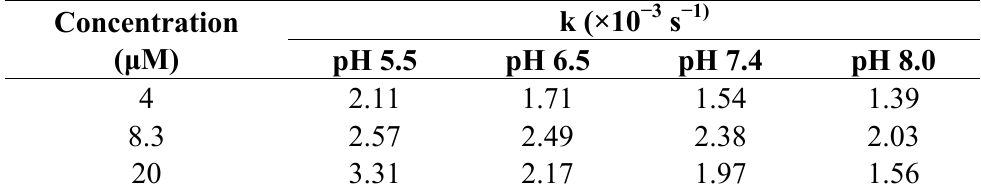
Table 5. Investigation for chemical degradation of